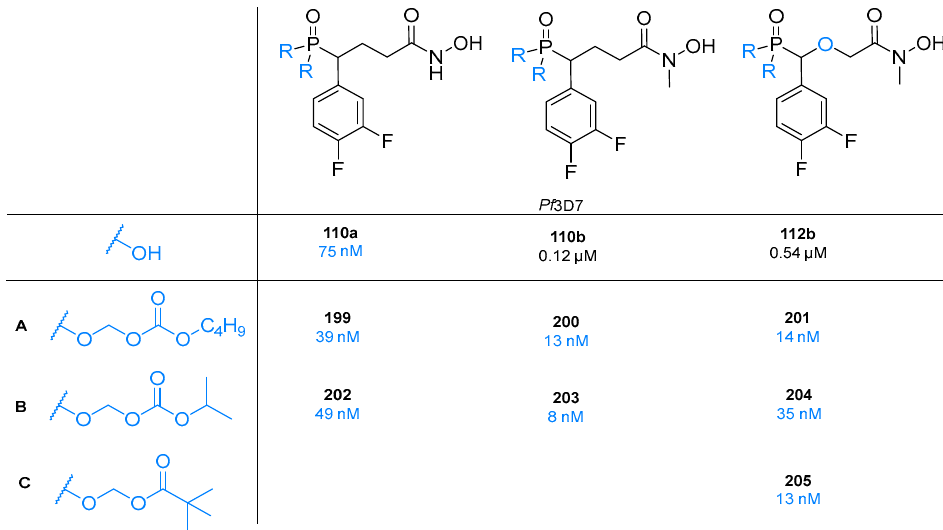
Figure 37. Antiplasmodial activity of parent compounds ( 110a , 110b , 114b ) and prodrugs ( 199 – 205 ) against Pf 3D7.